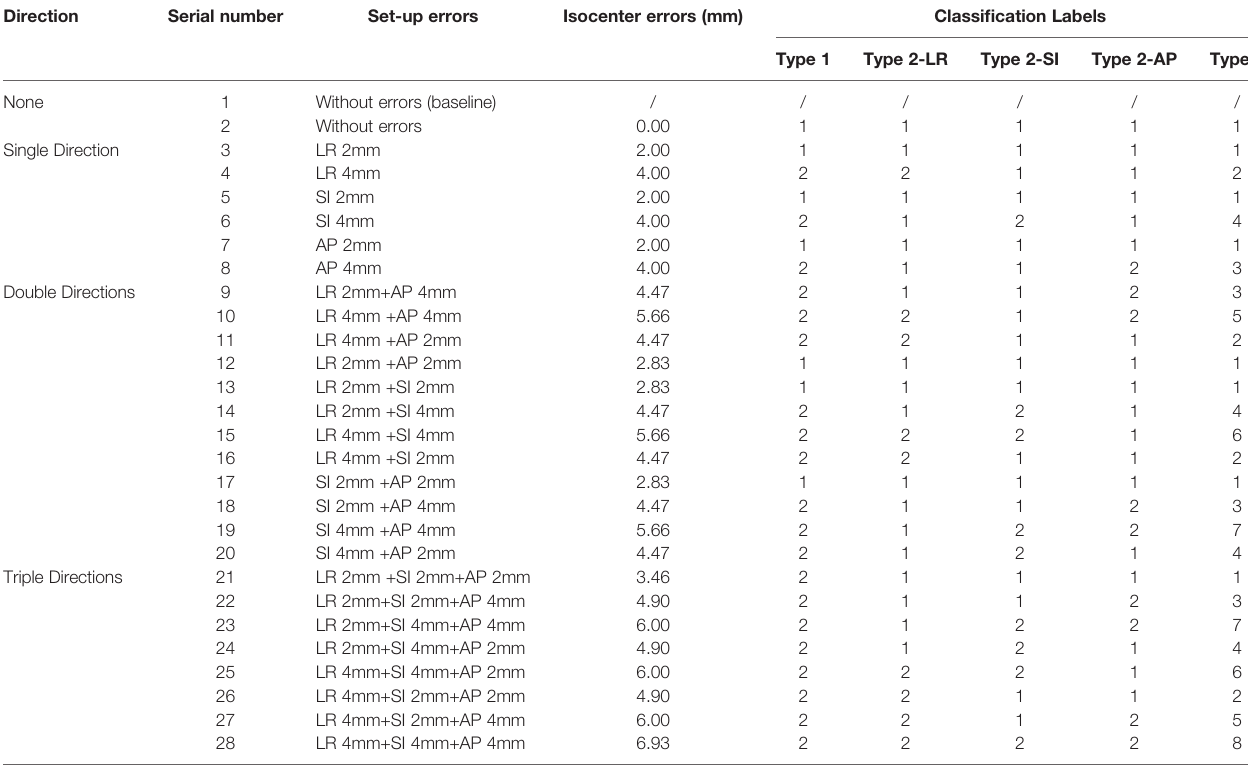
p ffiffiffiffiffiffiffiffiffiffiffiffiffiffiffiffiffiffiffiffiffiffiffiffiffiffiffiffiffiffiffiffiffiffiffiffiffiffiffiffiffiffiffiffiffiffiffiffiffiffiffiffiffiffiffiffiffiffiffiffiffiffiffiffiffiffiffiffiffiffiffiffiffiffi LR errors 2 + SI errors 2 + AP errors 2